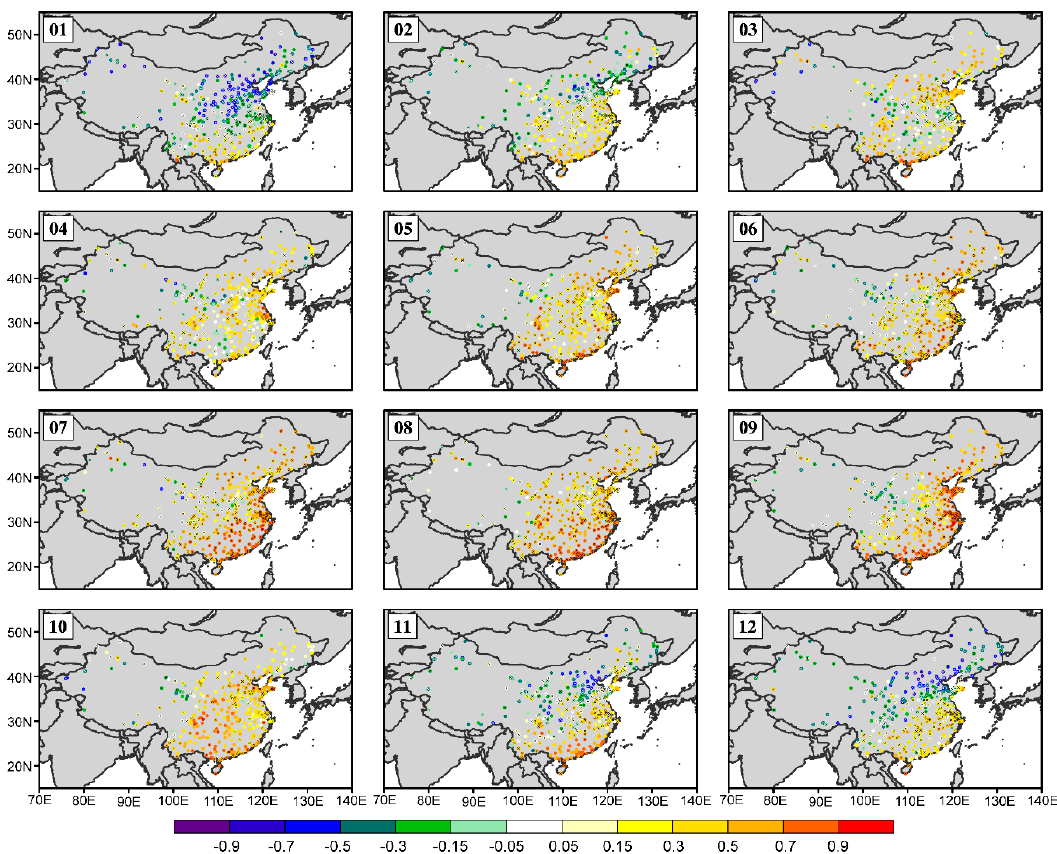
Figure 1. Spatial-temporal distributions of correlations between observed daily PM 2.5 and maximum daily 8 h average (MDA8) O 3 concentrations over China. Each panel represents each month for the year 2016. The dots with crosses are statistically significant at the 95% level.